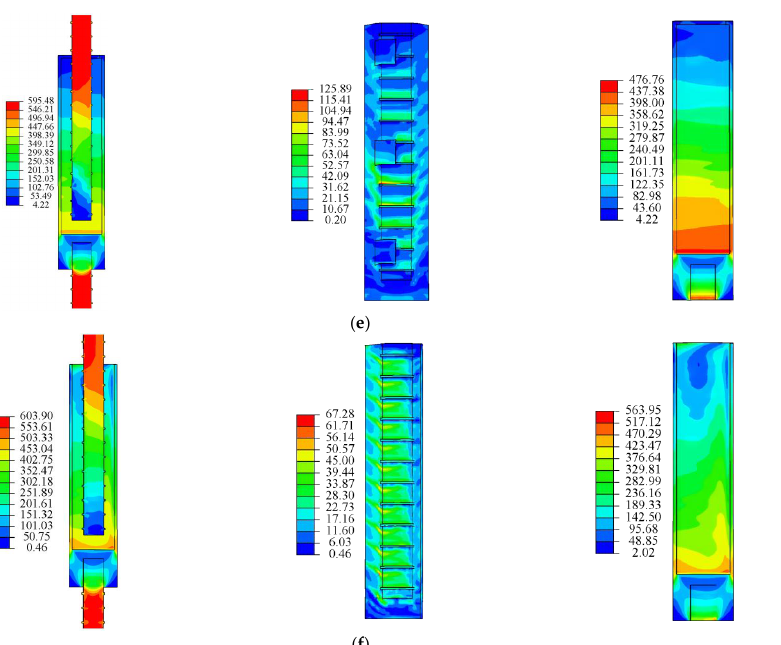
Figure 20. Stress nephograms. ( a ) GT14-BM. ( b ) GT14-DB-2.5 d. ( c ) GT14-ZB-2.5 d. ( d ) GT14-JB-3-2.5 d. ( e ) GT14-DC-3-2.5 d. ( f ) GT14-SP-4mm. ( e ) GT14-DC-3-2.5 d . ( f )